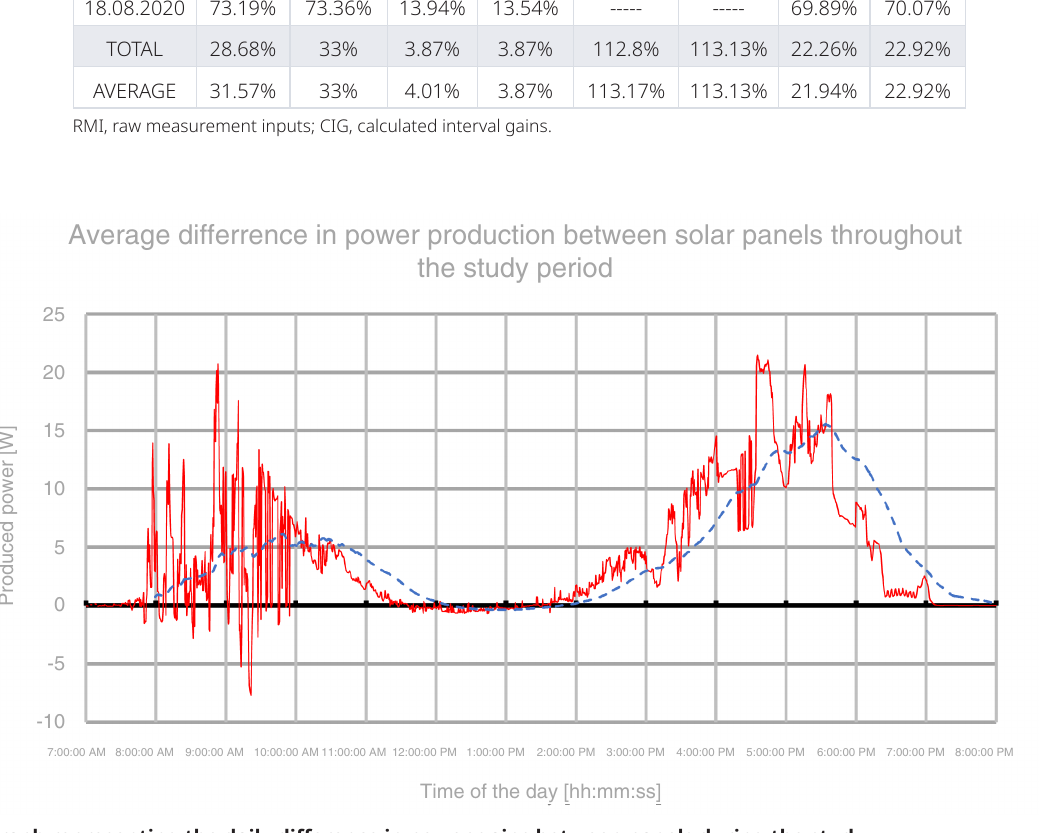
Figure 7. Graph representing the daily difference in power gains between panels during the